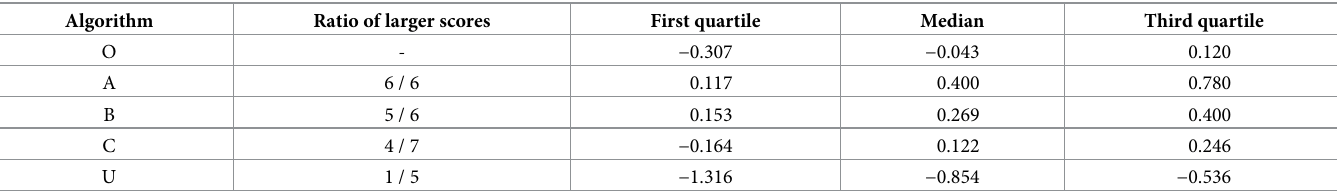
The selection ratio shows the number of subjects’ results with larger scores than those in the still image. The results for subjects who chose the parameter at 0 deg./s eliminated both the numerator and the denominator of the ratio, which suggests that the smaller denominator corresponds to a limited effect on the RSI